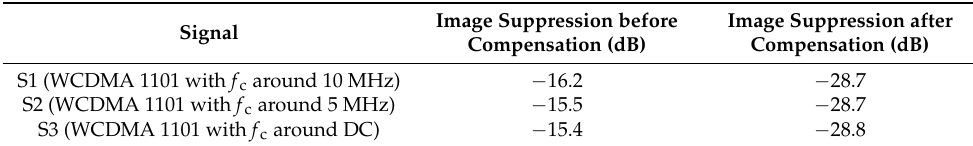
Table 2. IMGsup using proposed Methodology for g = 0.92 dB, g (cid:48) = 0.5 dB and θ = − 6 degrees, θ (cid:48) = − 2 degrees under 20 dB SNR.